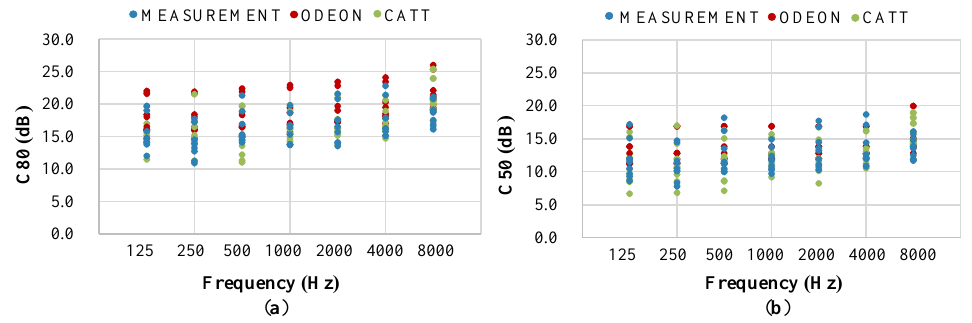
Figure 11. ( a ) Dispersion of C80 in measurement at point 1. ( b ) Dispersion of C50 in measurement at point 1.